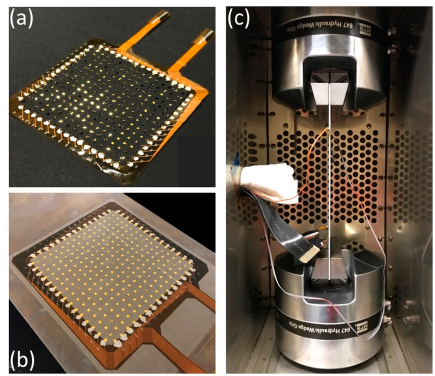
Figure 6. ( a ) Sensor network installed to a customized flexible printed circuit board for signal transmission; ( b ) Sensor network integrated to an aluminum sheet using vacuum bagging technique;